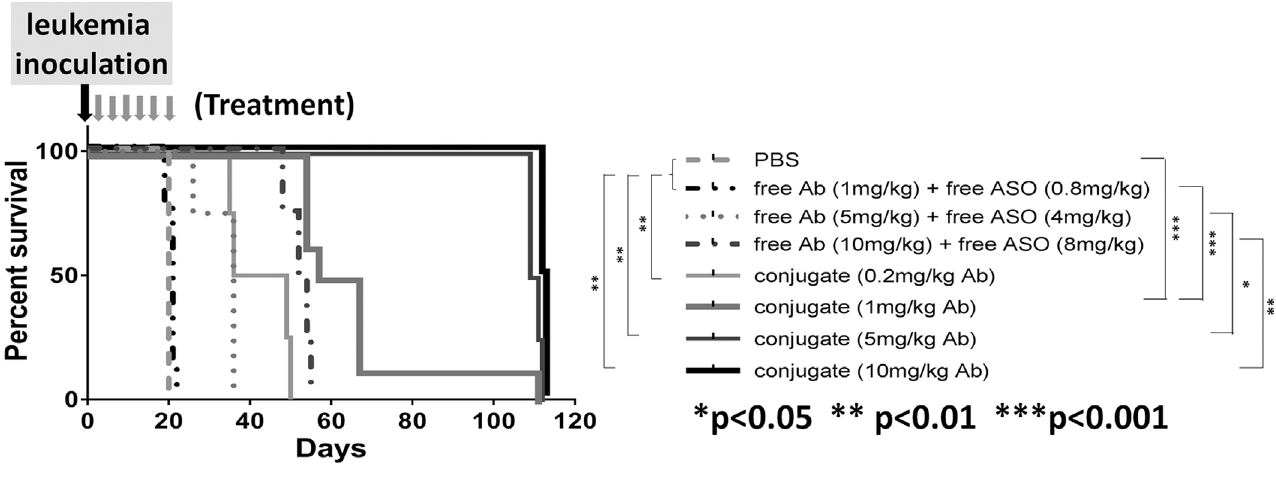
Figure 3. α CD22 Ab-MXD3 ASO conjugate shows significant in vivo dose-dependent therapeutic efficacy in Reh human leukemia mouse model. Kaplan-Meier survival curve for mice inoculated with Reh cells and treated with the α CD22 Ab-MXD3 ASO conjugate. Data from two independent experiments were combined (n = 4 or 8). In the first experiment, the mice were treated with PBS, free α CD22 Ab (1 mg/kg) plus free MXD3 ASO (0.8 mg/kg), and two different doses of the α CD22 Ab-MXD3 ASO conjugate (0.2 mg/kg or 1 mg/kg of the Ab). In the second experiment, the mice were treated with free α CD22 Ab (1, 5 or 10 mg/kg) plus free MXD3 ASO (0.8, 4 or 8 mg/kg), respectively, and three different doses of the α CD22 Ab-MXD3 ASO conjugate (1, 5 or 10 mg/kg of the Ab). PBS ver- sus conjugate at any dose (0.2, 1, 5 or 10 mg/kg of the Ab) (** p < 0.01, *** p < 0.001, ** p < 0.01 or ** p < 0.01, respectively). Free α CD22 Ab (1 mg/kg) plus free MXD3 ASO (0.8 mg/kg) versus conjugate at any dose (0.2, 1, 5 or 10 mg/kg of the Ab) (** p < 0.01, *** p < 0.001, ** p < 0.01 or ** p < 0.01, respectively). Free Ab plus free ASO versus conjugate at the equivalent dose of the Ab (1, 5 or 10 mg/kg)